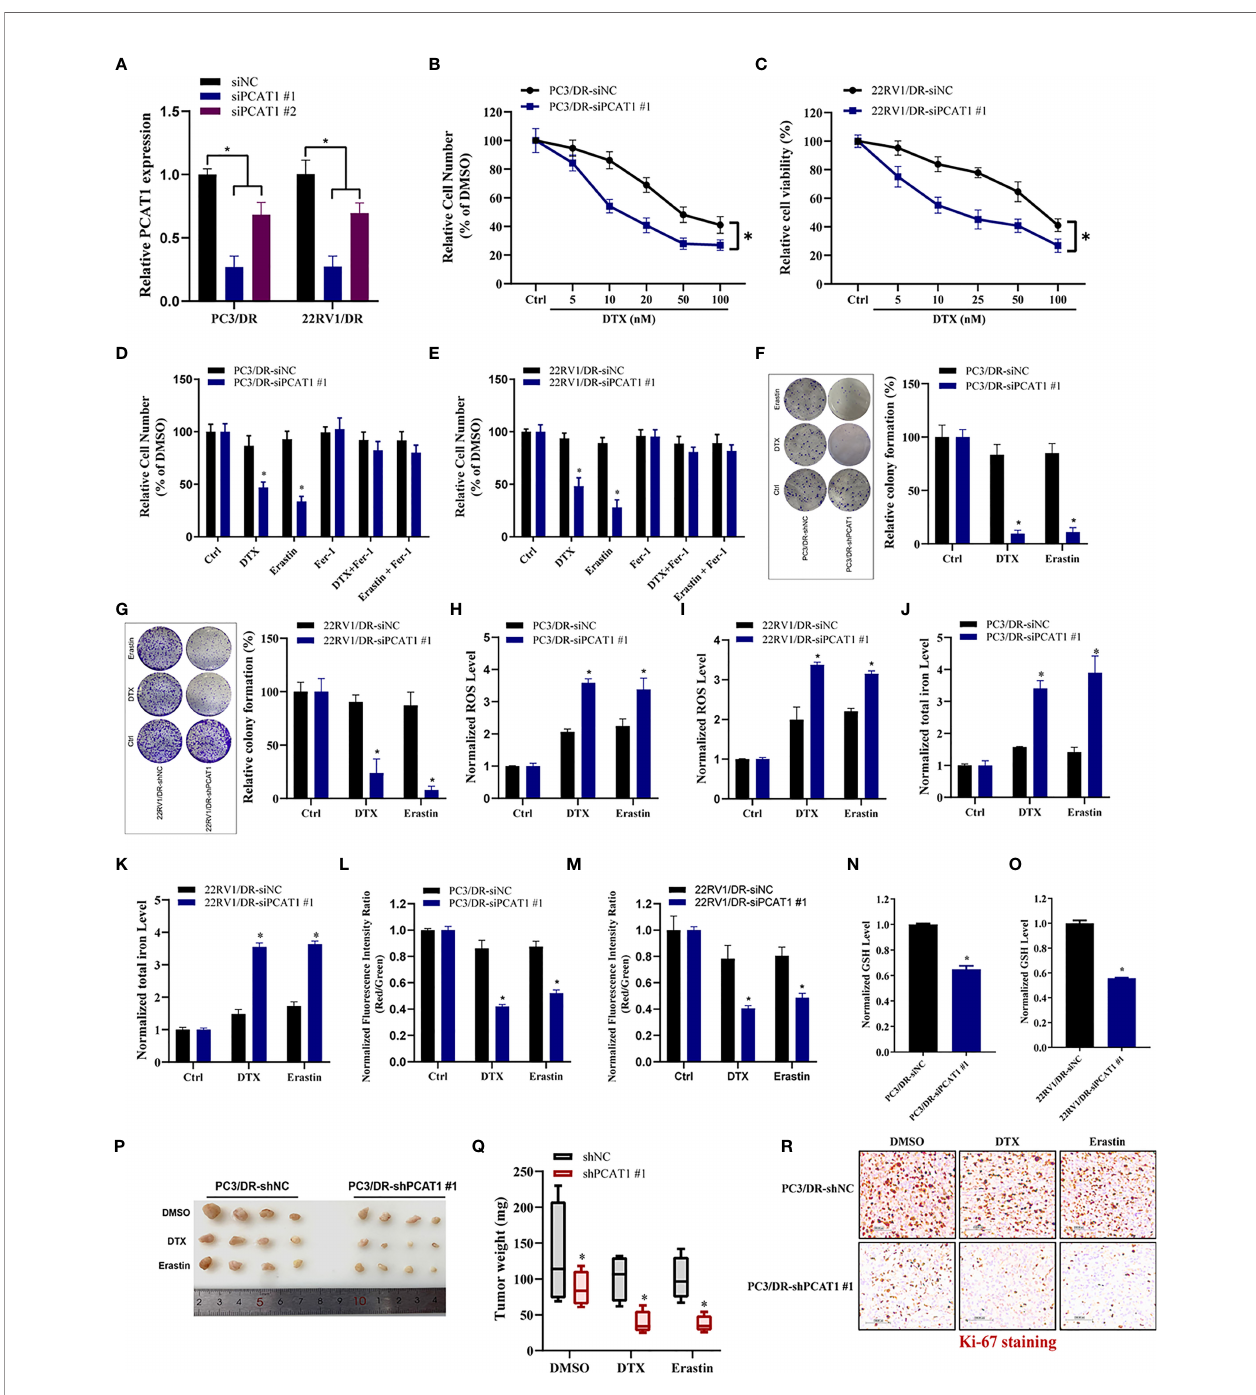
FIGURE 3 | PCAT1 knockdown promotes ferroptosis and impairs DTX tolerance. (A) The relative expression of PCAT1 was assessed by qRT-PCR in PC3/DR and 22RV1/DR cells after transfected with siPCAT1 and negative control siRNA. (B, C) The cell viability was evaluated in PC3/DR and 22RV1/DR cells after PCAT1 knockdown upon different dosage of DTX treatment for 72 hours. (D, E) CCK-8 assay was used to analyze the response of PCAT1-knockdown PC3/DR and 22RV1/DR cells to DTX, erastin and ferrostatin-1. (F, G) Colony formation assay was used to evaluate the cell growth in PC3/DR and 22RV1/DR cells after PCAT1 knockdown under DTX and erastin treatment. (H, I) Lipid ROS content, (J, K) total iron concentration, (L, M) the mitochondrial membrane potential were evaluated in PC3/DR and 22RV1/DR cells after PCAT1 knockdown upon DTX and erastin exposure. (N, O) The GSH content was assessed in PCAT1-knockdown PC3/DR and 22RV1/DR cells. (P) Representative images of xenograft tumors of PCAT1-knockdown PC3/DR cells after treated with DTX, erastin and DMSO, and (Q) The tumor weight were measured accordingly. (R) H&E and IHC staining were performed to evaluate tissue morphology and Ki-67 expression in PCAT1 knockdown tumors and their control tissues. The data are presented as the means ± S.D. of at least three independent experiments. * P